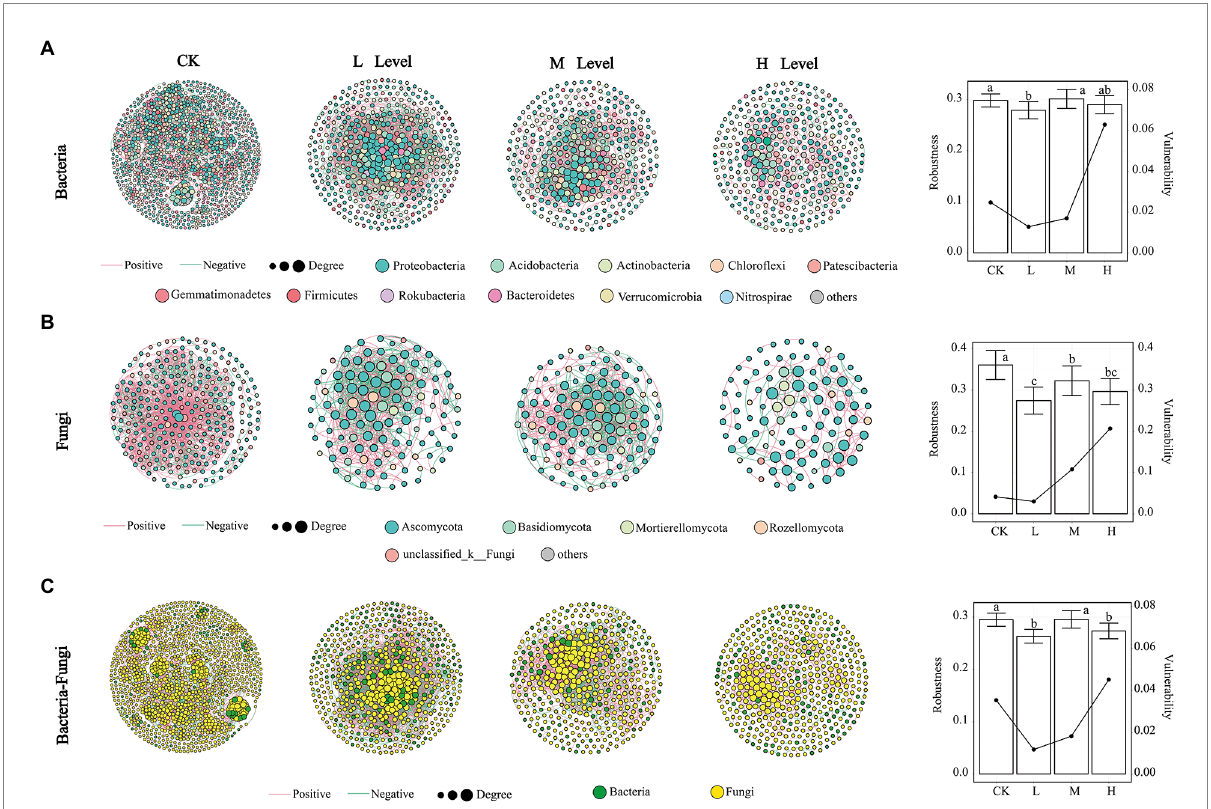
FIGURE 3 Co-occurrence networks, robustness, and vulnerability of bacterial (A) , fungal (B) , and bacterial–fungal (C) communities. The bar plot represents the robustness. Line graphs represent vulnerability. Different lowercase letters in the bars indicate significant differences among the different RI levels ( p <